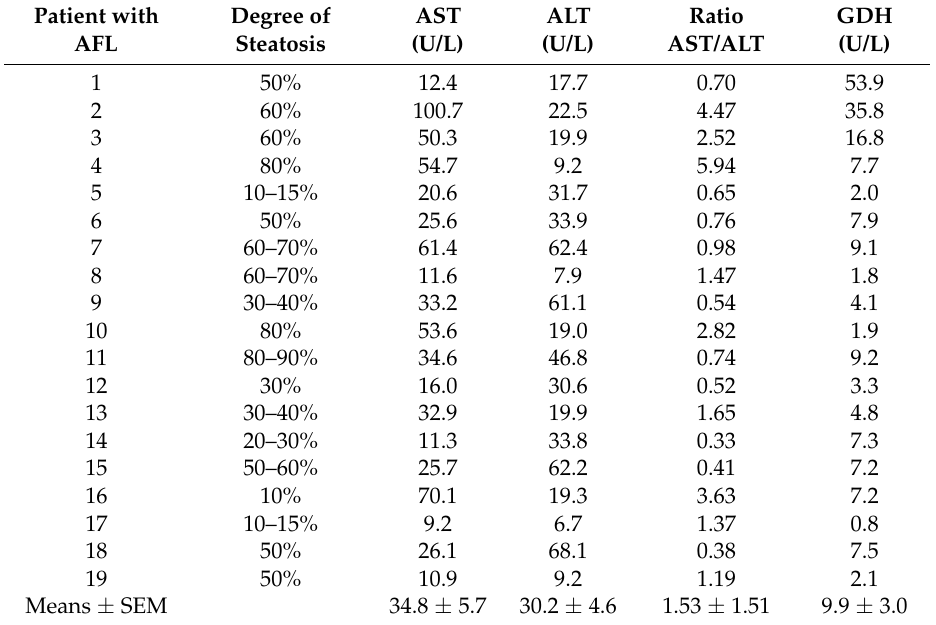
Table 7. Serum AST, ALT, and GDH activities in alcoholic fatty